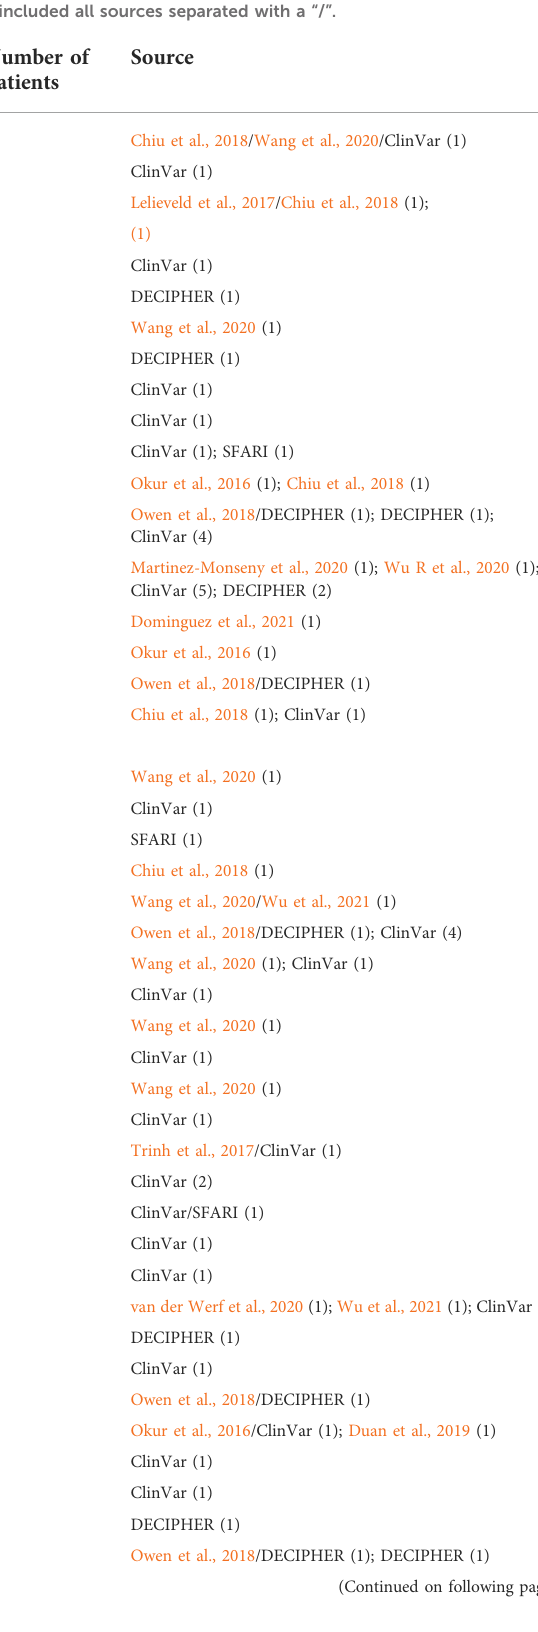
TABLE 1 CK2 α mutants associated with OCNDS phenotypes. Tables include nucleotide mutation, amino acid residue change (when applicable), numberofpatientspermutation andsource.(A)includesvariantsthataffectaminoacidresiduesand(B)includessplice variants.Totalnumberof patients for CK2 α was 129. For samples found duplicated in different sets, we included all sources separated with a “ / ”